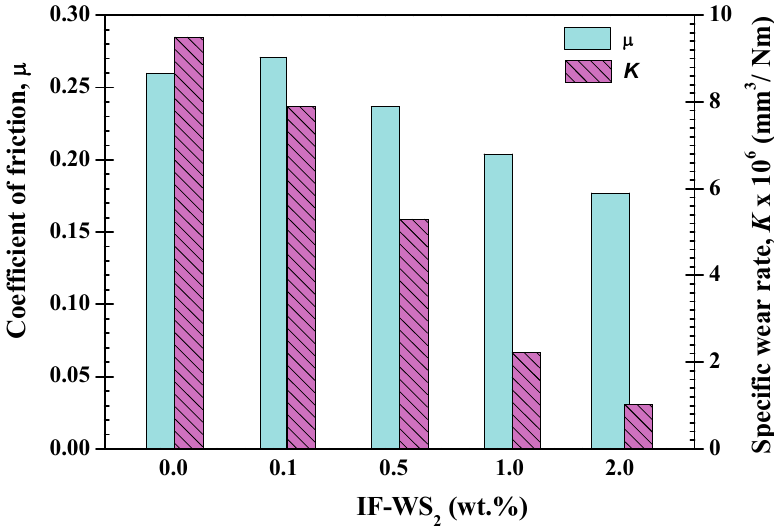
Figure 7. Coefficient of friction and wear rate of PPS/IF-WS of IF-WS content. 2